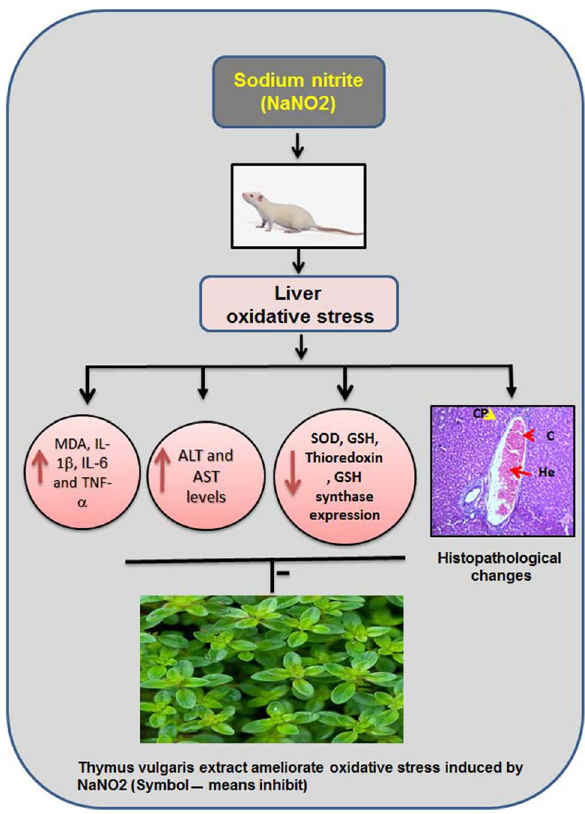
Figure 5. Schematic representation of the ameliorative effect of T. vulgaris extract on liver dysfunction. NaNO 2 intoxication induced hepatic dysfunction, decreased antioxidant activity, and an increase in the levels and expression of inflammatory cytokines. These results of treatment with NaNO 2 were normalized by pretreatment with T. vulgaris